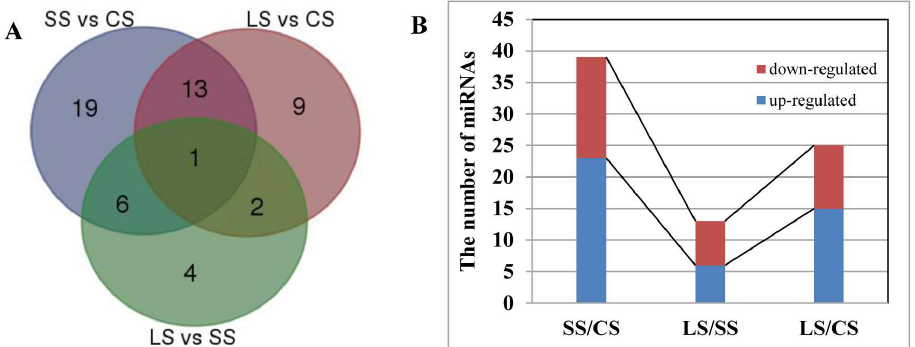
Figure 4. Significant differentially expressed miRNAs by ABA treatment in the stems of P. euphratica . ( A ) Venn diagram of significant differentially expressed miRNAs by ABA in the stems. ( B ) The number of up- or downregulated miRNAs responsive to ABA in the stems.